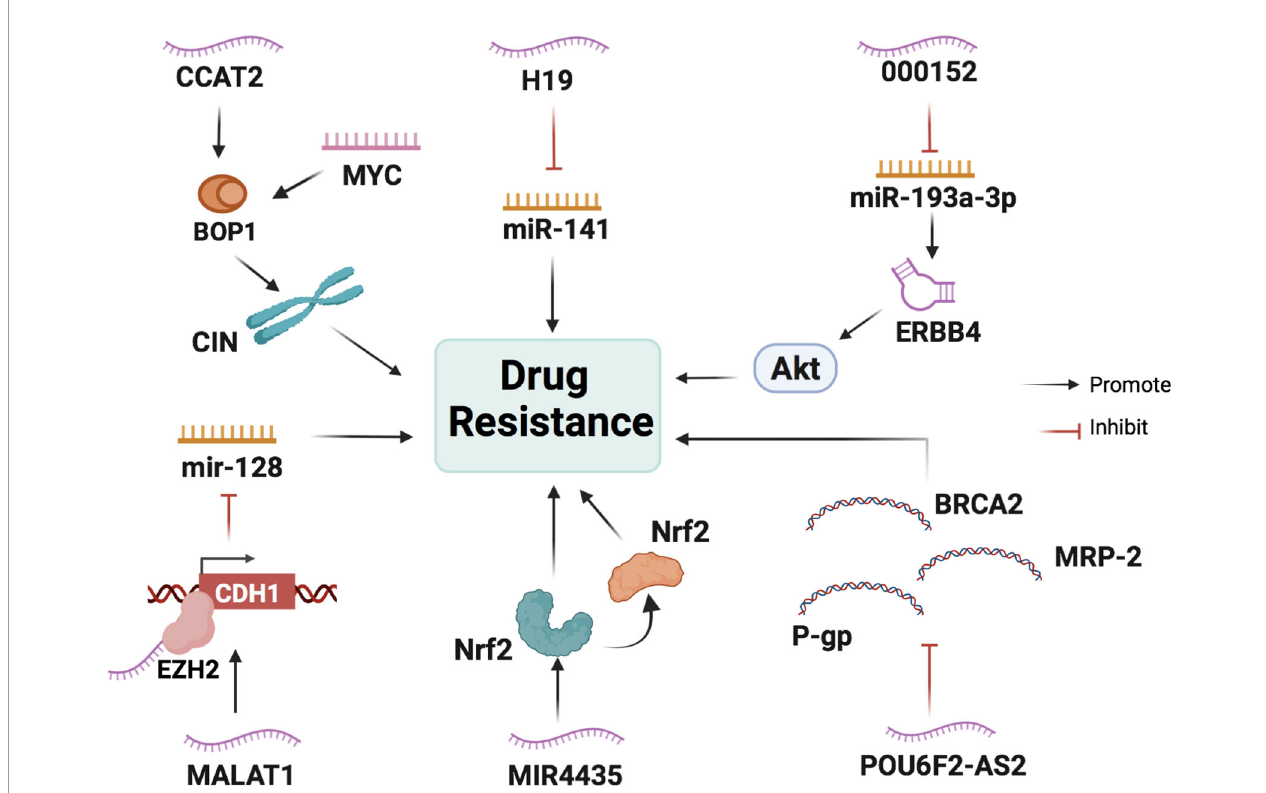
FIGURE 4 | The main mechanisms of lncRNAs in CRC cell drug resistance. LncRNAs participate in CRC cell drug resistance by acting as scaffolds or miRNA sponges and regulating the expression of transcriptional factors, ribosomal biogenesis factors, and